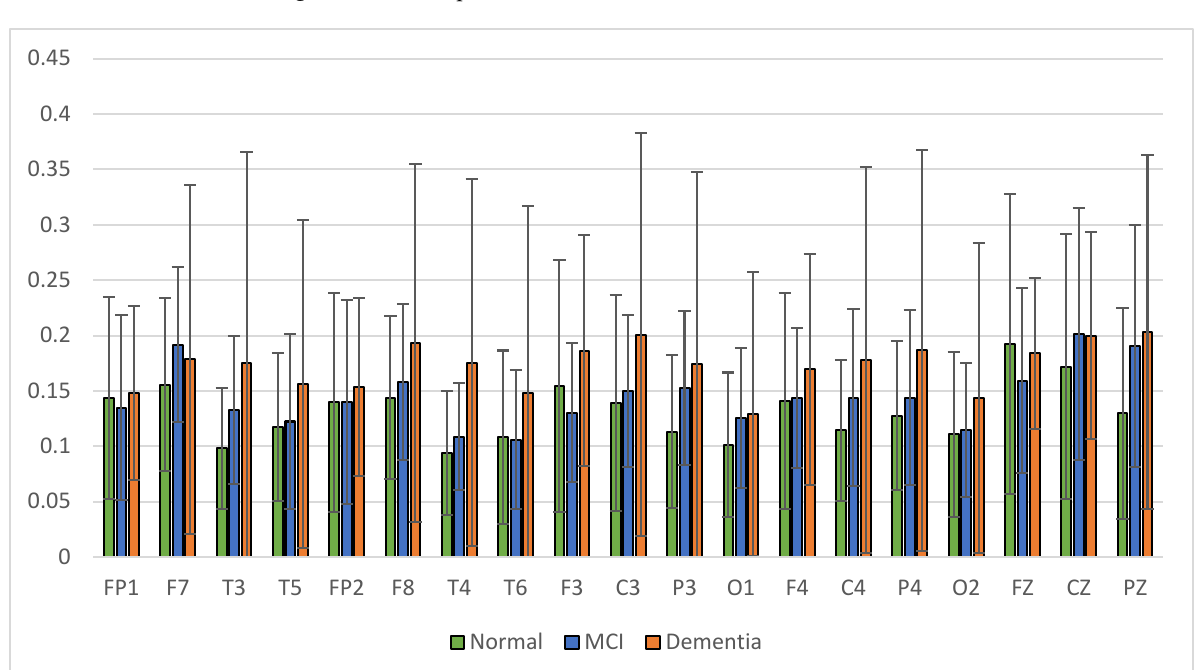
Figure 9. Relative power delta band.